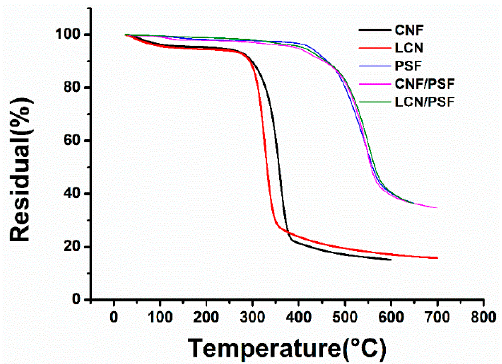
Figure 8. Thermal gravity analysis curves of CNF, LCN, Sample M0 (PSF), Sample M4 (CNF/PSF) and Sample M10 (LCN/PSF). Table 2. T onset and T max analysis of CNF, LCN, PSF, CNF/PSF and LCN/PSF.